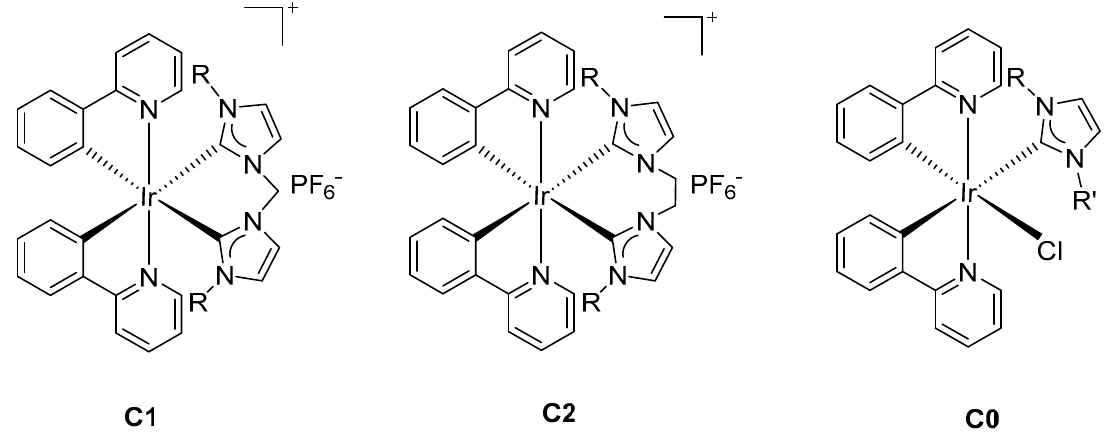
Figure 1. Three designed families of iridium(III) NHC complexes.